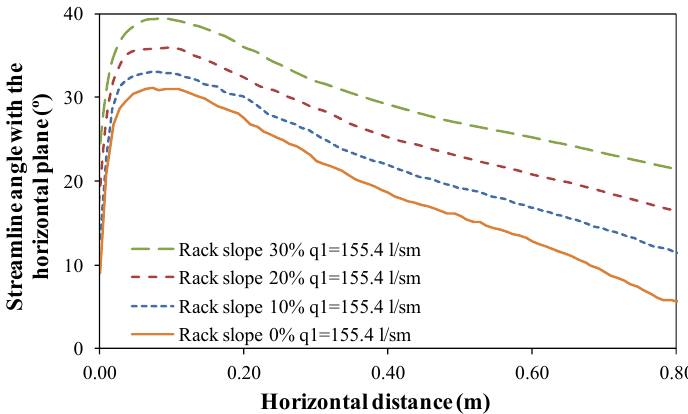
Figure 6. Angle of the velocity vector with the plane of rack C for q 1 = 155.4 l/s/m and different longitudinal rack slopes.